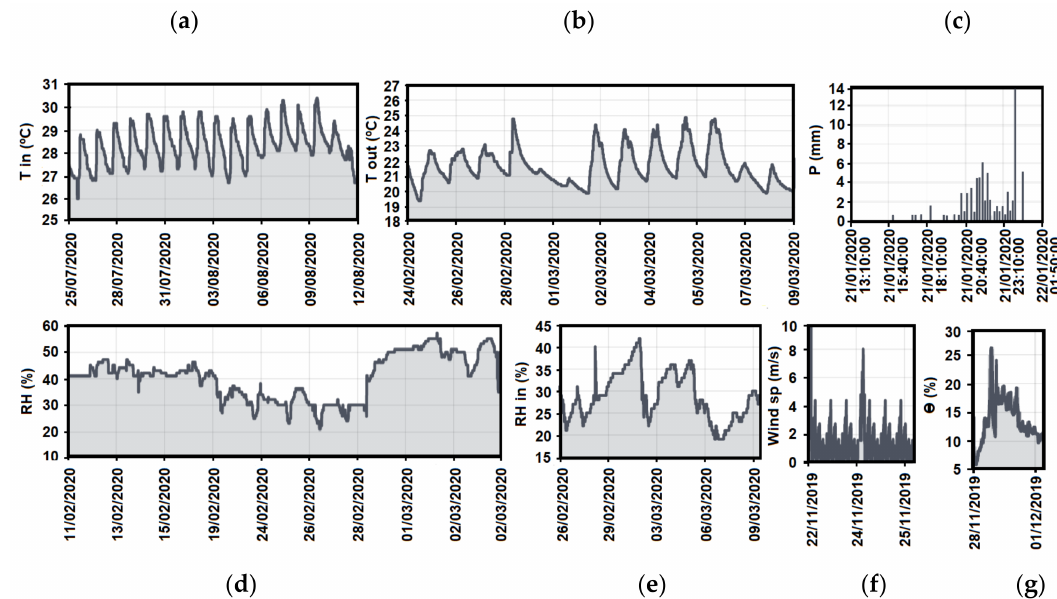
Figure 10. Meteorological monitoring system data at different times, as shown on the Web platform: ( a ) inside air temperature; ( b ) outside air temperature; ( c ) precipitation; ( d ) outside relative humidity; ( e ) inside relative humidity; ( f ) wind speed; ( g ) soil moisture water